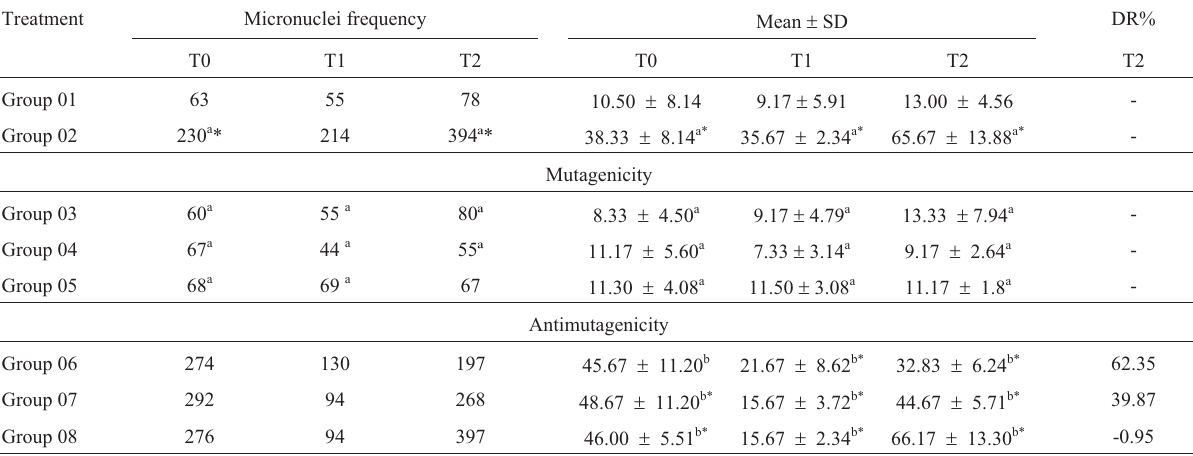
Table 4 - Frequency, mean (cid:4) SD and DR% for the micronucleus assay done on peripheral blood cells during the sixth week of treatment. Treatment